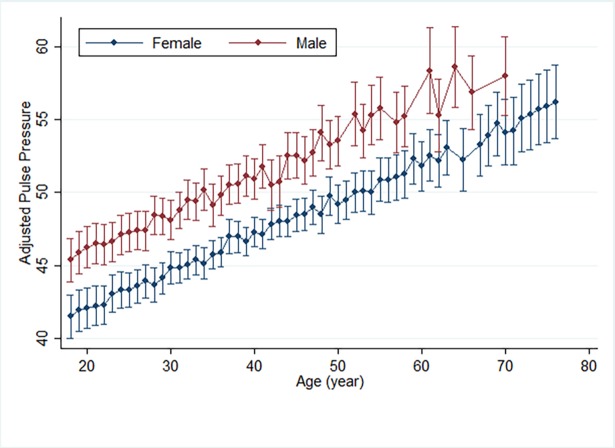
Mean pulse pressure distribution by gender and age, adjusted for hemoglobin.The median (IQR) for pulse pressure was 45 mmHg (39–55) and in linear regression analysis pulse pressure was associated with total hemoglobin (beta = -0.4 per mg/dl, P = 0.031), age (beta = 0.3 per year, P < 0.001) and male gender (beta = 4.4, P < 0.001) (Fig 2).